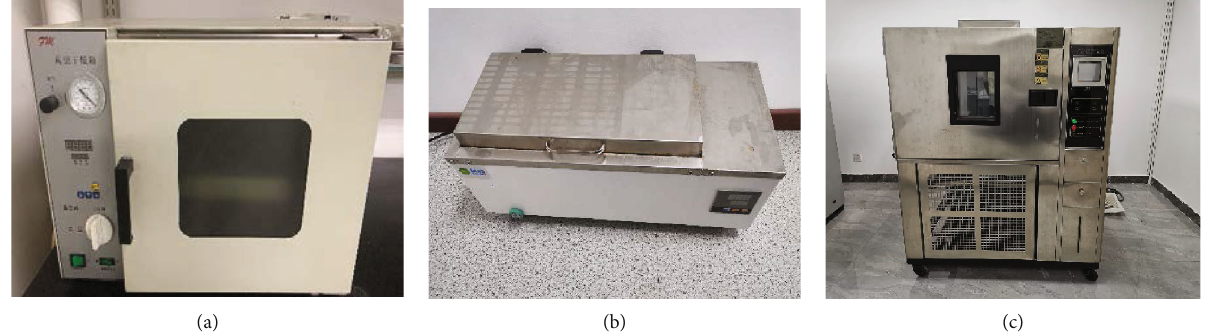
Figure 3: Experimental apparatus used for preparing cement mortar with di ff erent saturation levels [39]: (a) intelligent testing system for gaseous water adsorption in deep soft rock, (b) electronic thermostat water tank, and (c) vacuum